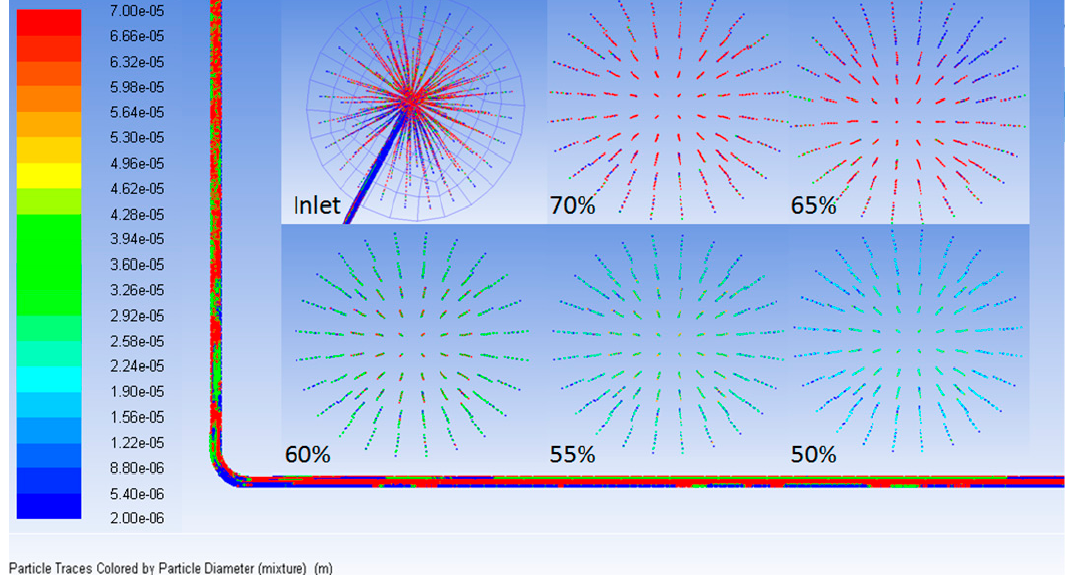
Figure 8. Distribution of discrete phase particle.